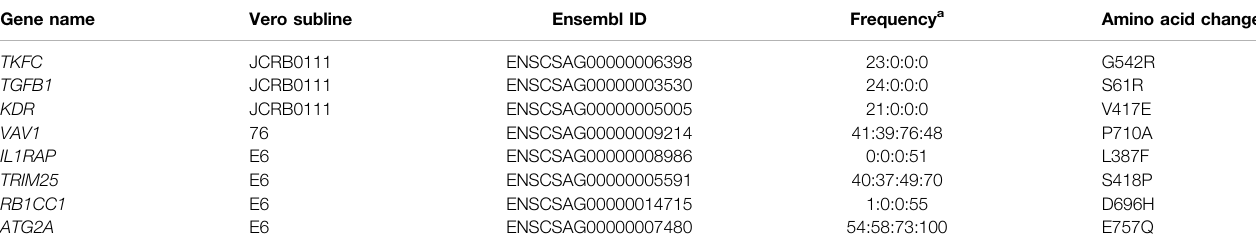
TABLE 3 | Subline-speci fi c/enriched missense SNVs in genes related to viral